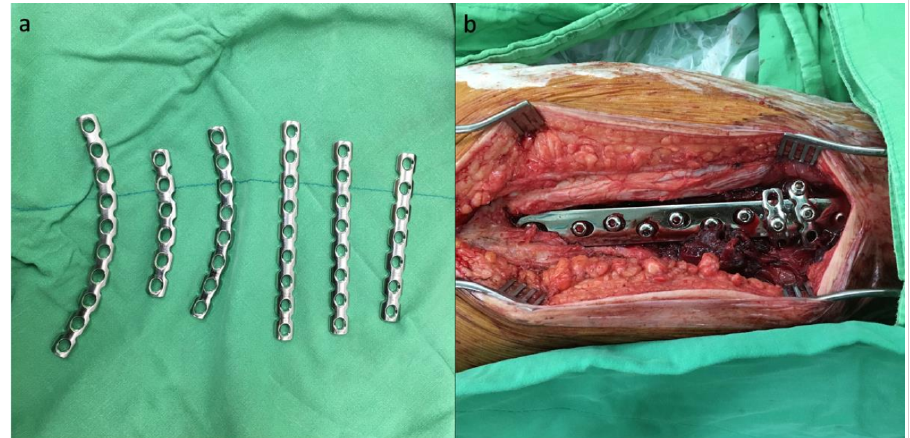
Figure 3. Surgical procedure of modified SHS: ( a ) a 3.5 mm AO reconstruction plate was chosen after consideration of the curve and length; ( b ) intraoperative photograph of the cerclage reconstruction